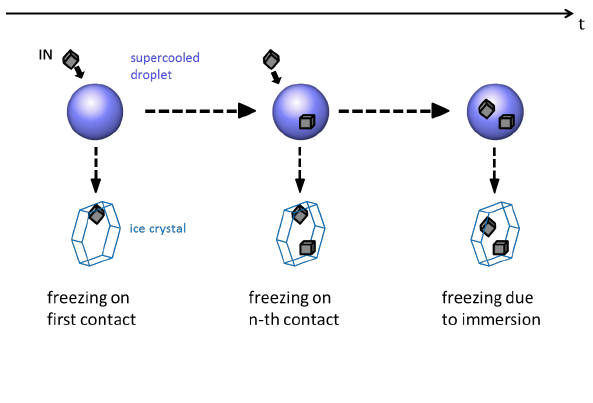
Fig. 4. Possible pathways of droplet